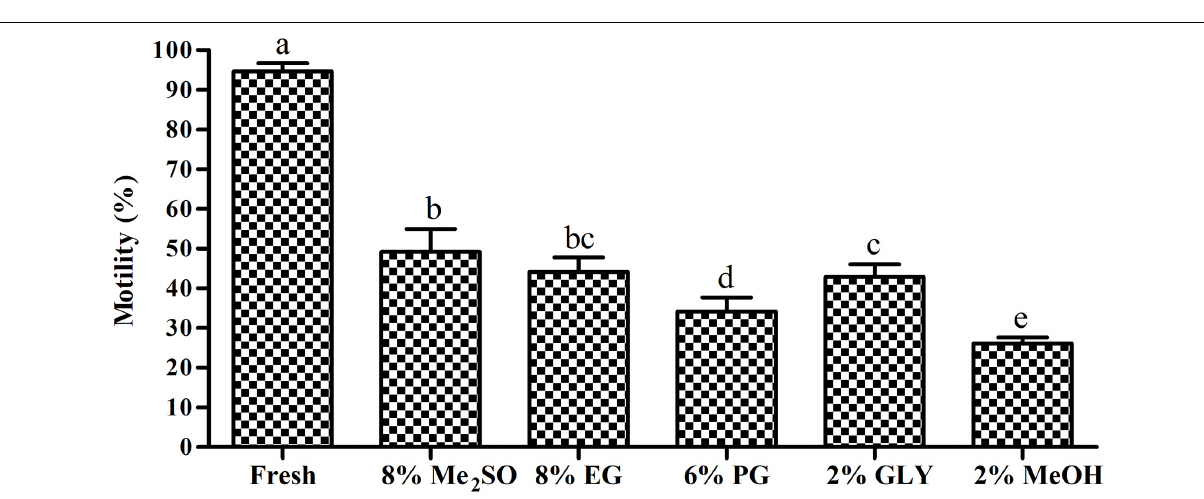
for sperm cryopreserved with 8% Me 2 SO, 8% EG, or 2% GLY ( p >